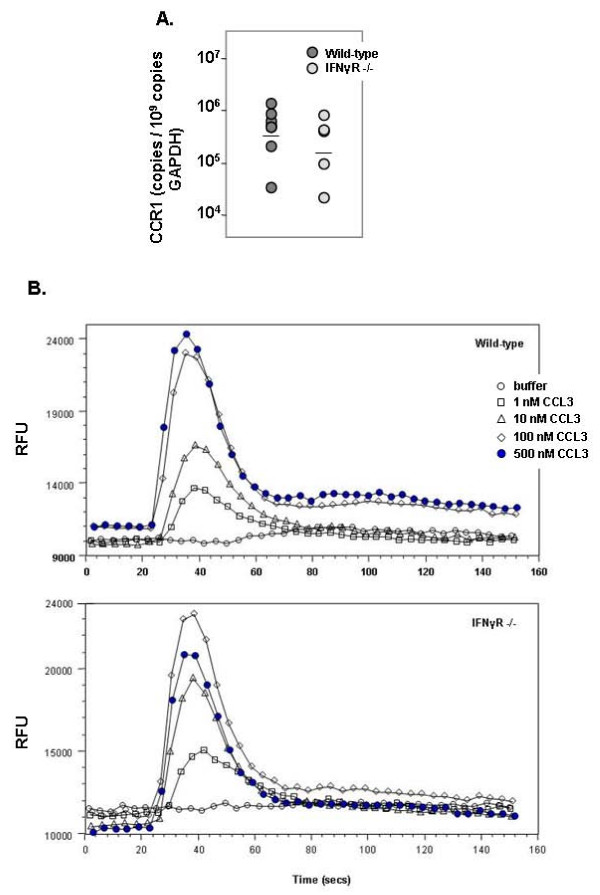
Comparison of wild type and IFNγR gene-deleted neutrophils. (A) Expression of CCR1 transcript in wild type and IFNγR gene-deleted neutrophils (n = 9 and 6 independent samples, respectively) determined by quantitative RT-PCR; horizontal line denotes mean copy number. (B) Calcium flux (RFU) measured in response to increasing concentrations (0 – 500 nM) of CCL3.